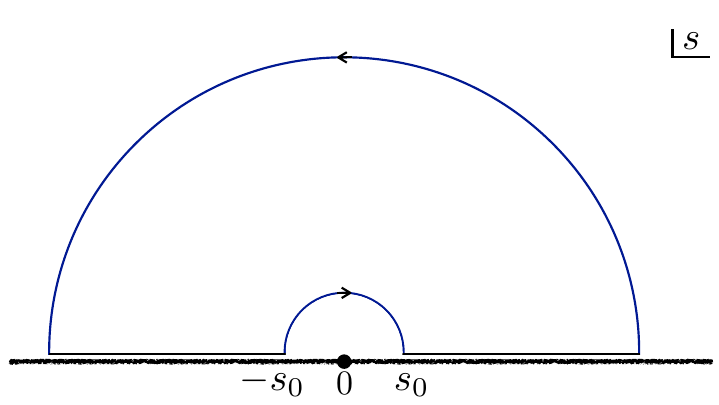
Figure 6 . Closed integration contour in the s -complex plane used to derive (C.13). We assume the integrand decays sufficiently fast at large | s | so that we can drop the arc at infinity. The forward amplitudes are analytic in the upper half plane and satisfy the crossing property (C.5). There are branch cuts along the real axis emanating from the branch point s = 0 .